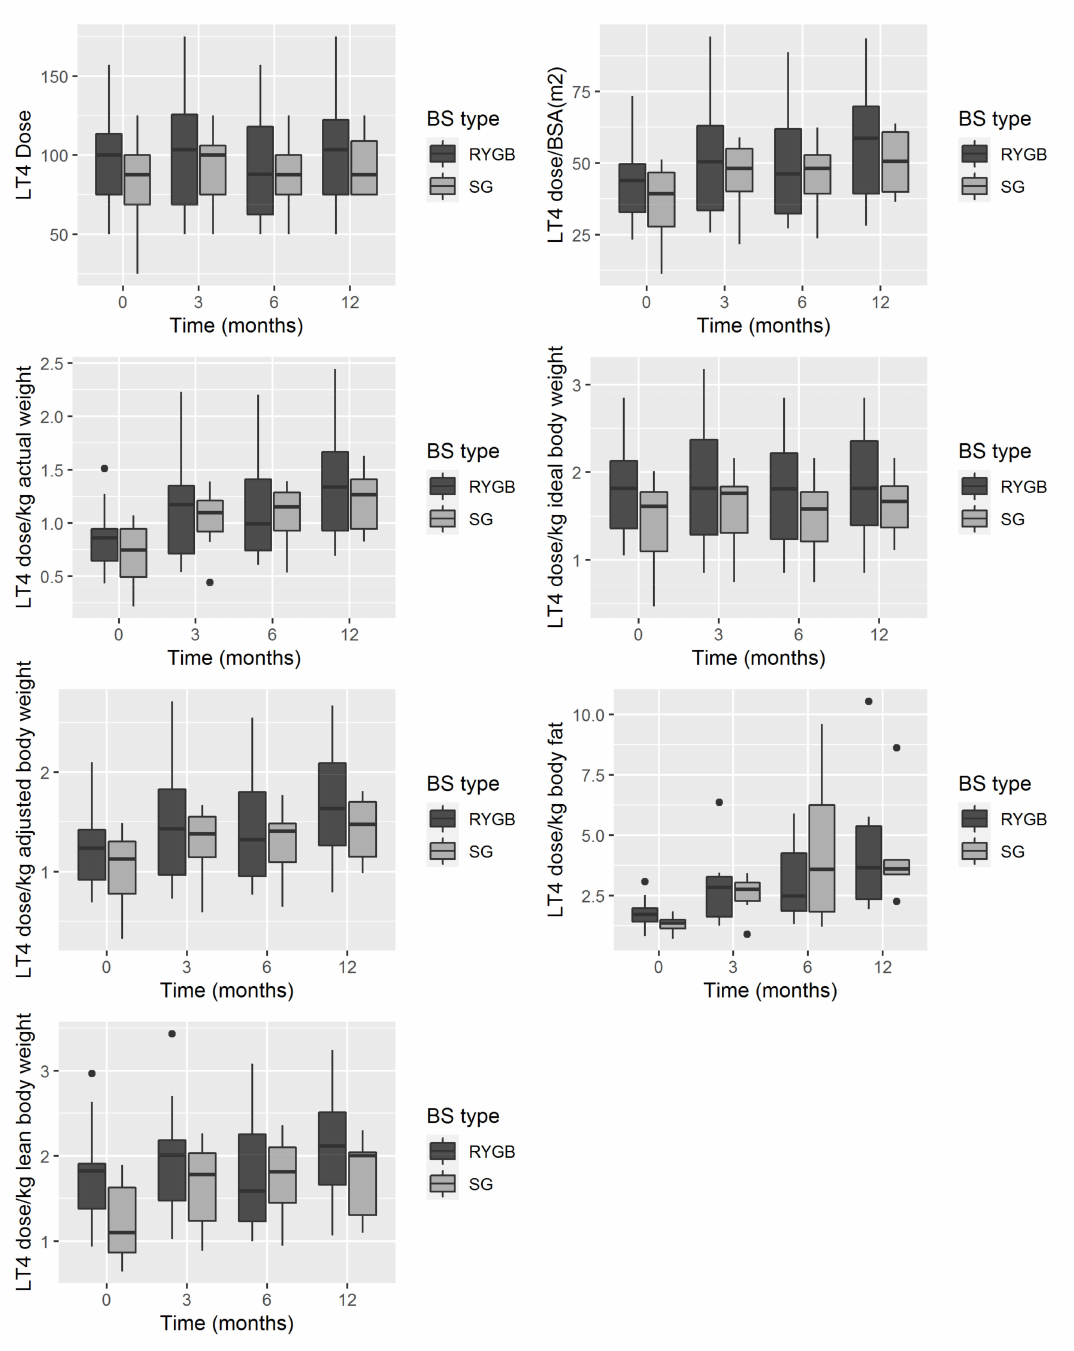
Figure 2. Levothyroxine (LT4) dose (median, interquartile ranges) change in hypothyroid patients after bariatric surgery (BS), according to BS type, sleeve gastrectomy (SG) or Roux-en-Y gastric bypass (RYGB). • , are